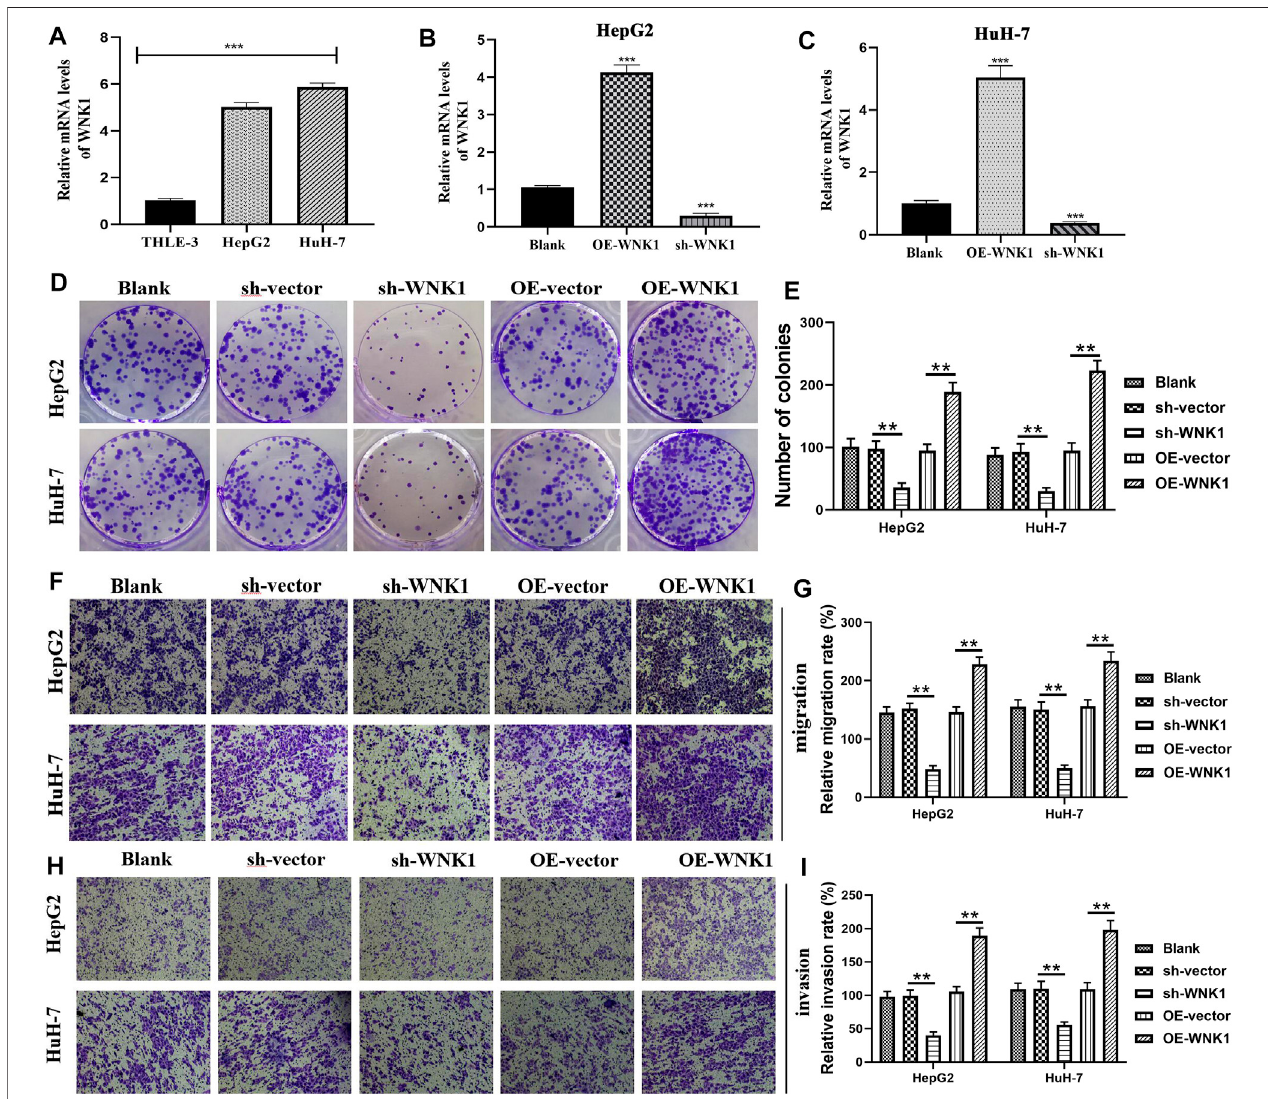
FIGURE 9 | WNK1 promotes the malignant behaviors of hepatoma cells. (A) The expressive differences of WNK1 between normal liver epithelial (THLE-3) and hepatoma cells (HepG2 and Huh-7). (B – C) sh-WNK1 and OE-WNK1 effectively alter the mRNA expressions of WNK1. (D – E) WNK1 is proven to promote the proliferation ofhepatoma cells through colony formation assays. (F – G) Transwell migration assays reveal that WNK1 enhances the migratory abilities of hepatoma cells. (H – I) Transwell invasion assays reveal that WNK1 enhances the invasive abilities of hepatoma cells. shRNA, short hairpin RNA; OE, overexpression plasmid; * p < 0.05, ** p < 0.01, *** p <